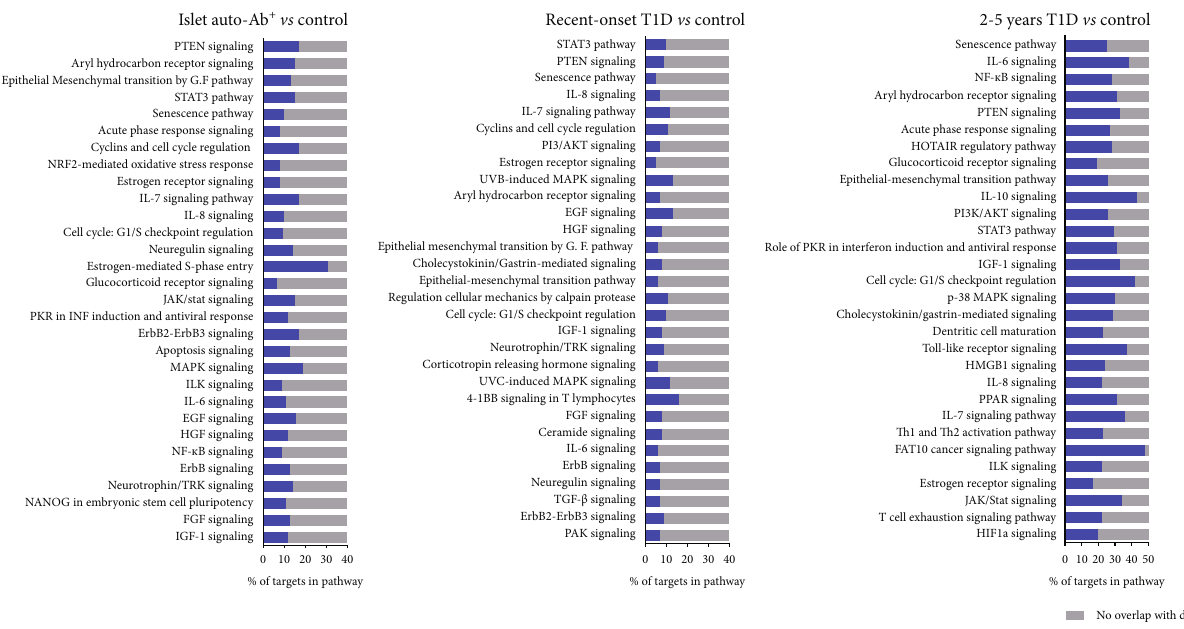
Figure 6: Ingenuity Pathway Analysis (IPA). Canonical pathways most signi fi cantly enriched by serum miRNAs from the AbP group (individuals with islet autoantibodies without diabetes; n = 25 ), recent-onset type 1 diabetes (T1D) group (newly diagnosed T1D patients with duration ≤ 6 months; n = 30 ), and T1D 2-5y group (patients with T1D with 2 to 5 years of duration; n = 26 ) in comparison with health controls. The stacked bar chart displays the percentage of target DEGs molecules present in each pathway. The Benjamini- Hochberg method was used to adjust the right-tailed Fischer ’ s exact test p value, which was always < 0.001.